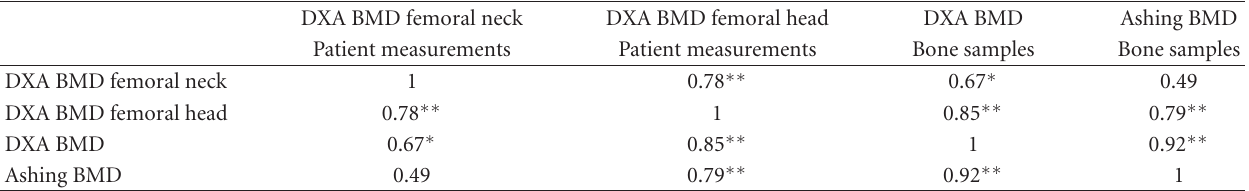
Table 2: Linear correlation between the BMD measured on each patient and BMD of the respective bone samples.